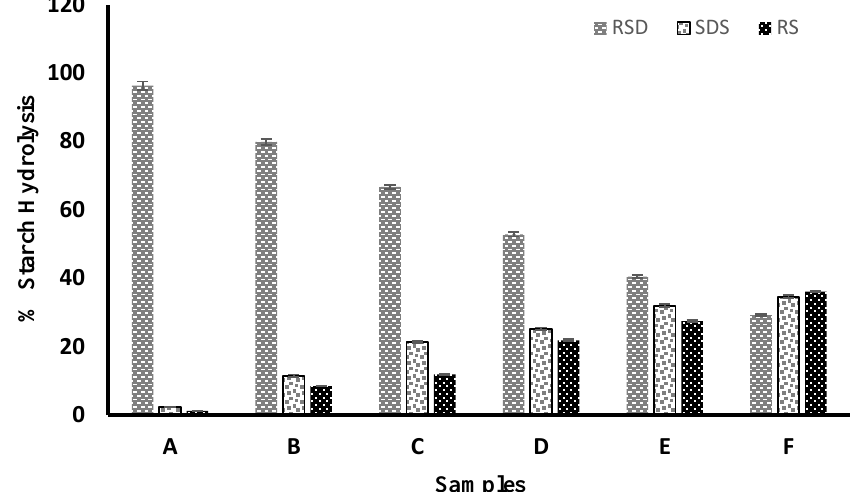
Figure 1. In vitro starch digestibility of composite flour made from wheat and unripe pawpaw fruit flour. Keys: A is 100% wheat flour; B is 90% wheat and 10% mature, unripe pawpaw fruit flour; C is 80% wheat and 20% mature, unripe pawpaw fruit flour; D is 70% wheat and 30% mature, unripe pawpaw fruit flour; E is 60% wheat and 40% mature, unripe pawpaw fruit flour; F is 50% wheat and 50% mature, unripe pawpaw fruit flour.